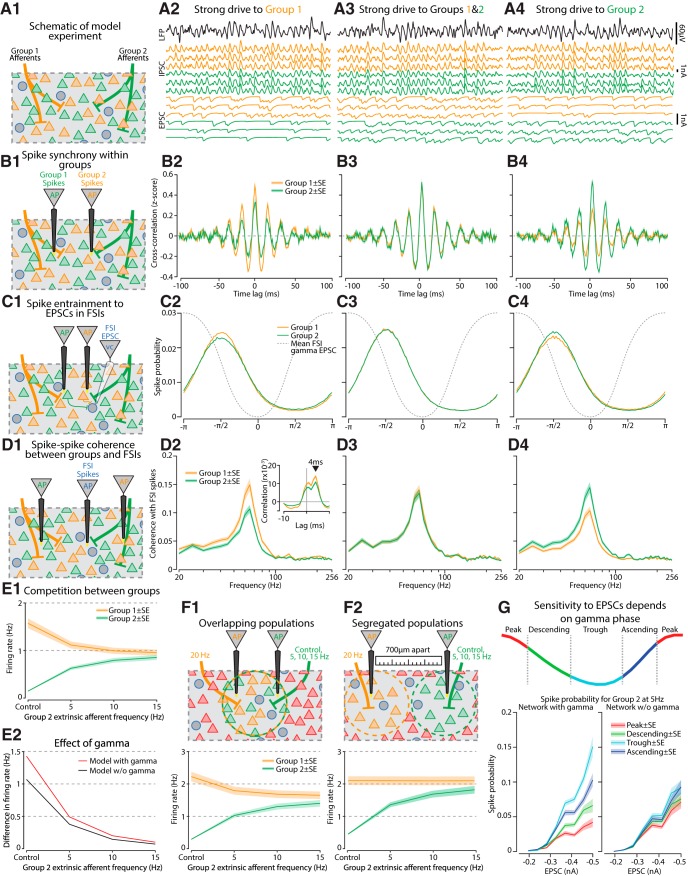
Gamma promoted synchrony between PNs responding to extrinsic afferents and the competition between weakly and strongly driven populations. A, Two separate ensembles of PNs were targeted by extrinsic afferents (group 1, orange vs group 2, green), that received different subsets of afferents. Groups could be driven independently, with (2) group 1 receiving 20-Hz stimulation while group 2 had 5 Hz; (3) group 1, 20 Hz and group 2, 20 Hz; or (4) group 1, 5 Hz and group 2, 20 Hz. B, (1) Spikes were recorded from both groups of PNs and (2–4) we calculated their cross-correlation functions. C, (1) Spikes from PNs and the mean EPSC across all FSIs were recorded. (2–4) Probability histograms of the EPSC gamma phases associated with spiking from either group 1 or group 2. The strongly driven group exhibits greater entrainment. D, (1) The coherence between PN spiking and FSI spiking for each group. (2–4) FSIs were more coherent in the gamma-band with the population that received the strongest afferent drive. Inset, PN preceded FSI spiking by 4 ms on average. E, (1) Group 1 receives 20-Hz extrinsic drive while group 2 receives a varying amount. Increasing the firing rate of extrinsic afferents onto group 2 diminished the firing rate of group 1. (2) The difference in firing rate between these groups was weakened when connections from PNs to FSIs were removed. F, Analysis of competition between groups in the full model when they either (1) fully overlap or (2) are entirely segregated in space. G, top, Gamma cycles were divided into four phases and for each phase the spike probability was measured as a function of the EPSC strength. Bottom left, For the weakly driven group there was increased sensitivity for EPSCs during the trough and ascending phases of gamma, but a dampening of responsiveness during the descending and peak phases. Bottom right, When connections from PNs to FSIs were removed, the discrepant sensitivities for EPSCs across the four phases were diminished. Graphs are either mean or mean ± SE when a shaded region is present.